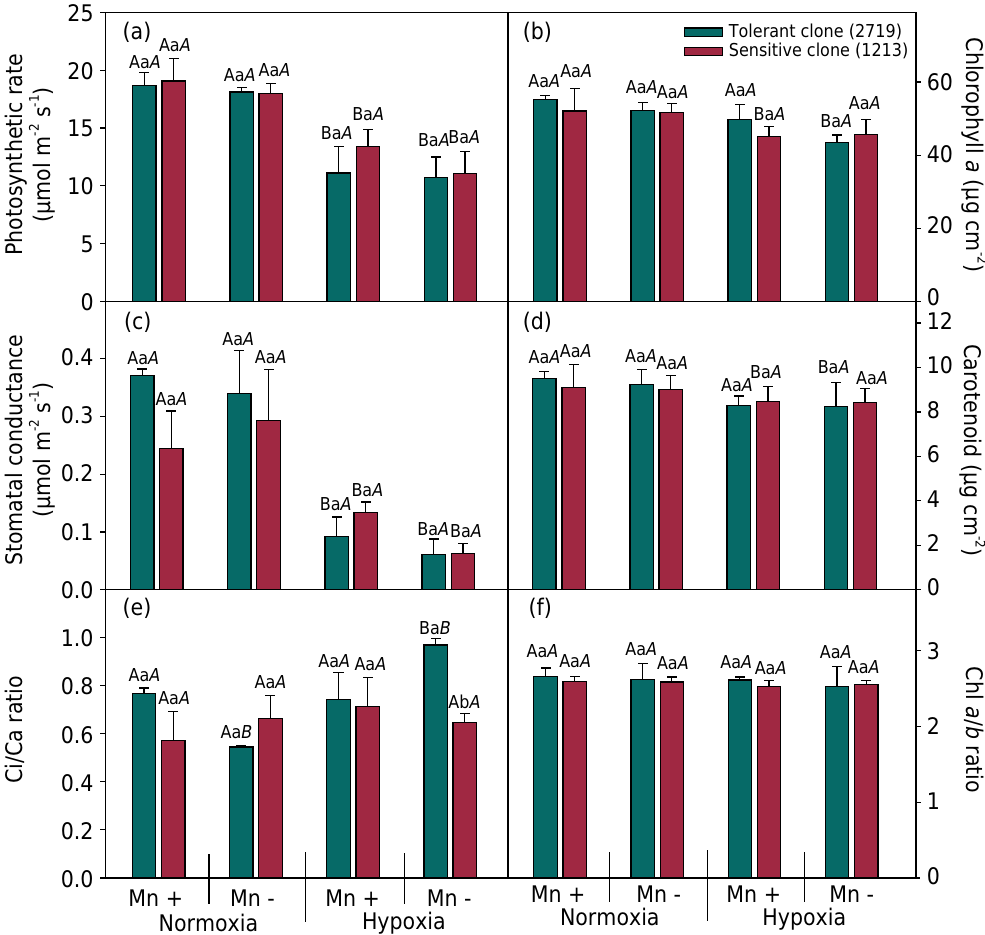
Figure 3. Gas exchange and pigment levels in leaves from two Eucalyptus clones in hydroponics in response to the treatments. Photosynthetic rate (a); Level of chlorophyll a (b). Stomatal conductance (c). Carotenoid level (d). Internal carbon concentration (e). Chlorophyll a to chlorophyll b ratio (f). Uppercase letters compare the effect of O 2 (normoxia: 8 mg L -1 and hypoxia: 4 mg L -1 ) for the same clone and the same Mn concentration. Lowercase letters compare the effect of clones (tolerant and sensitive to VRDSD) for the same concentrations of Mn and O 2 . Uppercase italic letters compare the effect of the Mn concentration of the nutrient solution (300 and 1.39 mg L -1 ) for the same clone and the same O 2 concentration. Equal letters do not differ statistically at the level of 5